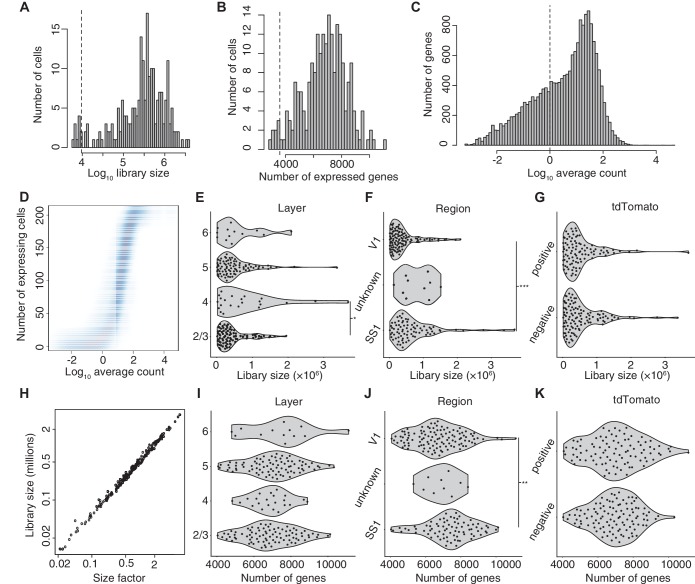
Quality control criteria for single-cell RNA-sequencing data, related to Figure 2C,D.(A and B) Histograms of library size (A) and number of genes expressed (B) for all sequenced cells. Cells falling more than three median absolute differences below the median (dotted lines) were excluded (n = 11 based on library size and n = 8 based on number of genes expressed; all 8 cells excluded based on number of genes are also excluded based on library size, leaving 206 out of 217 sequenced cells passing these combined criteria). (C) Histogram of average number of counts per cell across genes. Genes with less than one count per cell on average (dotted line) were excluded from further analyses (n = 12,841 genes passing this criteria). (D) Correlation between average number of counts per cell and total number of cells expressing each gene, across genes. (E–G) Library sizes of cells in different layers (E; n = 87, 22, 84, and 13 cells in layers 2/3, 4, 5, and 6 respectively; One-way analysis of variance with post-hoc pairwise comparisons using Tukey’s honestly significant difference procedure), different cortical regions (F; n = 79, 10, and 117 cells in primary somatosensory (SS1), unknown, and primary visual (V1) areas respectively; One-way analysis of variance with post-hoc pairwise comparisons using Tukey’s honestly significant difference procedure), and with (positive) or without (negative) tdTomato-expression (G; n = 110 and 96 negative and positive cells respectively; One-way analysis of variance). (H) Correlation between size factors used for normalization and library size, across cells. (I–K) Number of genes expressed by cells in different layers (I; n = 87, 22, 84, and 13 cells in layers 2/3, 4, 5, and 6 respectively; One-way analysis of variance), in different cortical regions (J; n = 79, 10, and 117 cells in SS1, unknown, and V1 areas respectively; One-way analysis of variance with post-hoc pairwise comparisons using Tukey’s honestly significant difference procedure), and with (positive) or without (negative) tdTomato-expression (K; n = 110 and 96 negative and positive cells respectively; One-way analysis of variance). Values are raw data points expressed as scatter plots (D and H, D with smoothing), binned (A–C), or with overlay violin plots (E–G and I–K). Only significant (p<0.05) p-values are shown (*p<0.05; **p<0.01; ***p<0.001).